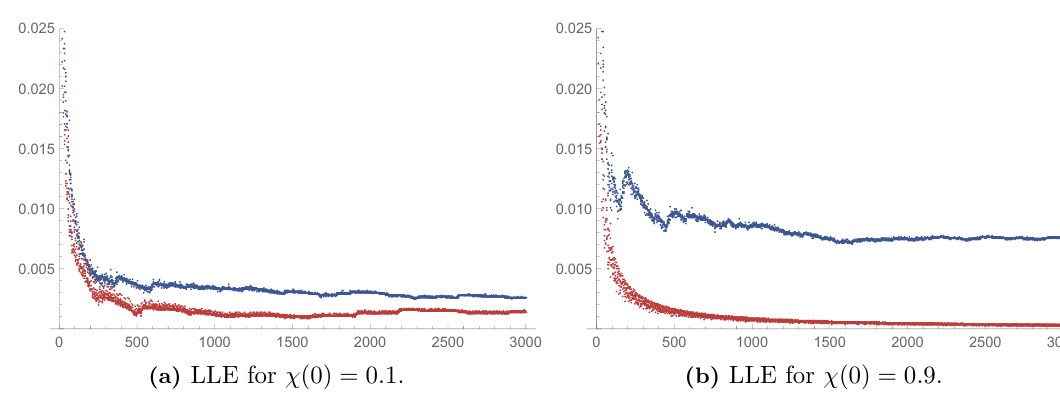
Figure 7. Lyapunov exponents for low- (left) and high-energy (right) string con(cid:12)gurations,